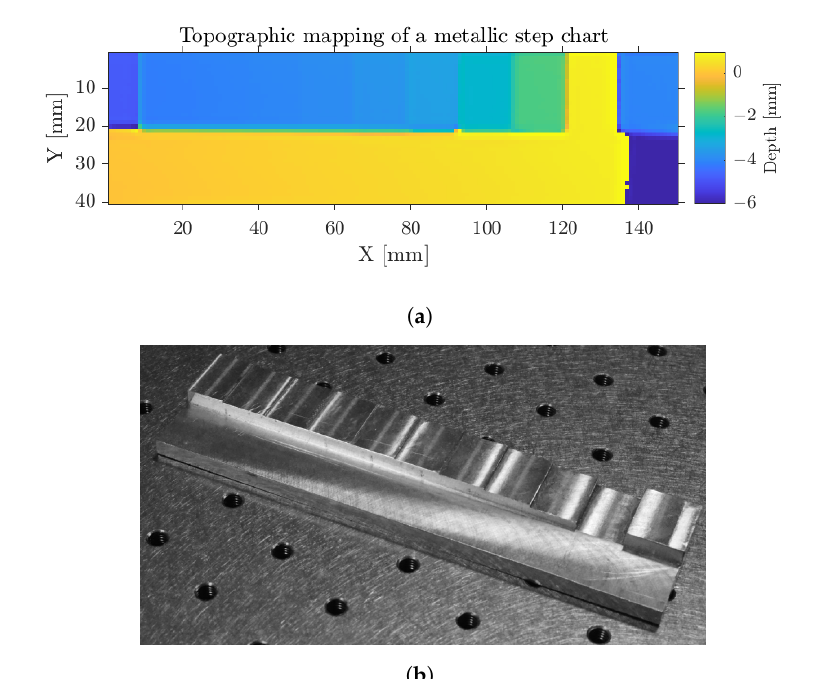
Figure 10. ( a ) Topographic mapping of a metallic step chart and ( b ) photography of the sample. Table 3. Longitudinal accuracy